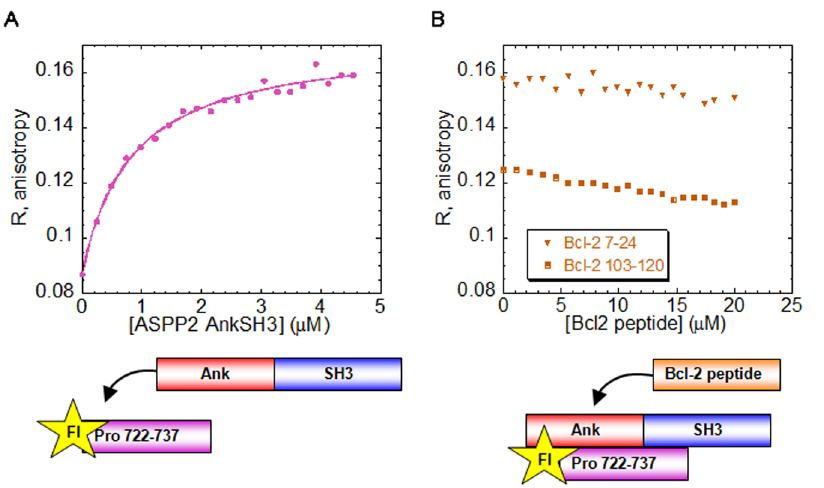
Figure 6. ASPP2 Ank-SH3 binds ASPP2 722–737 and is not displaced by Bcl-2 peptides. (A) ASPP2 Ank-SH3 binds Fl-ASPP2 722–737 with K d =0.82 6 0.08 m M (magenta); (B) Non-labeled Bcl-2 103–120 (orange square) or Bcl-2 7–24 (orange triangle) peptides were titrated into the fully formed complex between Fl- ASPP2 722–737 and ASPP2 Ank-SH3 but did not compete with ASPP2 Ank-SH3 on peptide